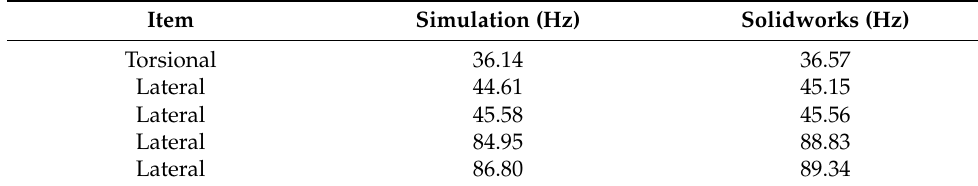
Figure 10. FE model of rotor. Table 2. Free-free